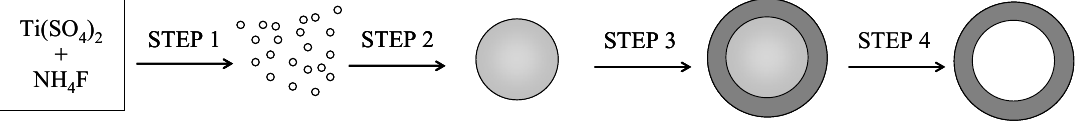
microspheres by 2